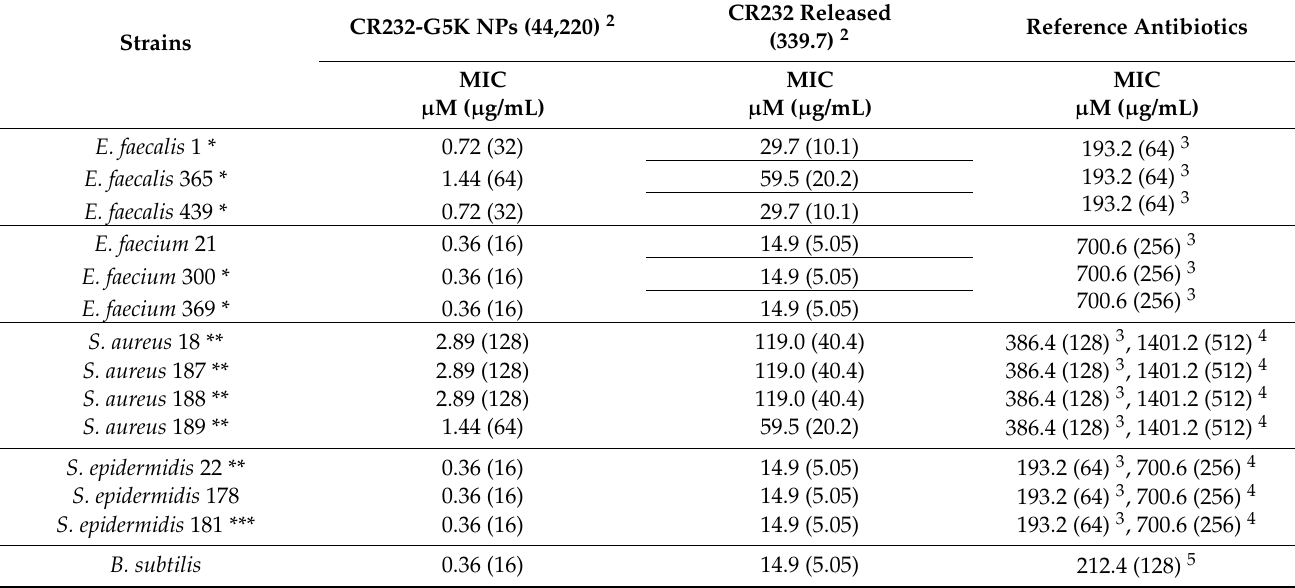
Table 4. MIC values of CR232-G5K NPs and those estimated for the CR232 (free compound) delivered by the dendrimer formulation against bacteria of Gram-positive species, obtained from experiments carried out in triplicate 1 , and those of reference antibiotics expressed as µ M and µ